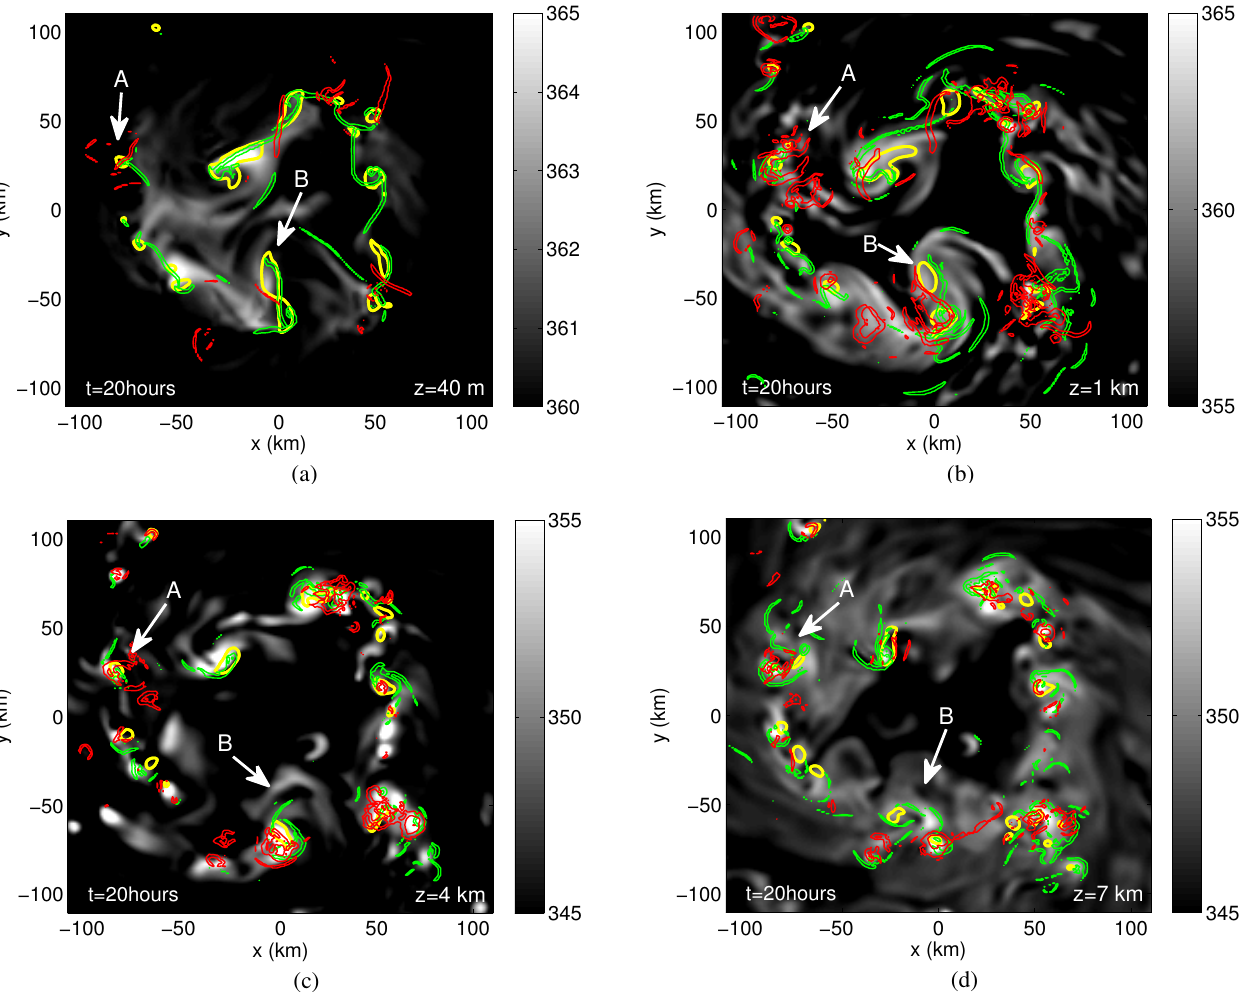
Fig. 7. The vertical structure of the LCSs are shown by attracting LCSs (green) and repelling LCSs (red), which with vorticity contours (yellow) are all overlaid on the θ e field (black and white shading) at vertical levels of 40 m (a), 1 km, (b), 4 km (c), and 7 km (d).